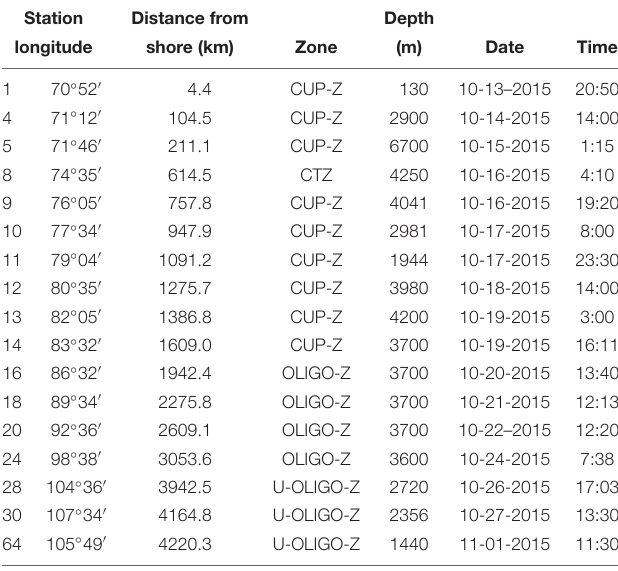
coupled with a mass spectrometer isotope ratio (DELTA V The IRMS). Abundance values of natural stable isotopes were reported as δ 15 N or δ 13 C ( ) relative to atmospheric nitrogen and Vienna Pee Dee Belemnite, respectively (Coplen, 2011). The associated isotopic error was 0.218 and 0.43 TABLE 1 | Description of the sampling stations used for the study from the coast to open ocean waters.